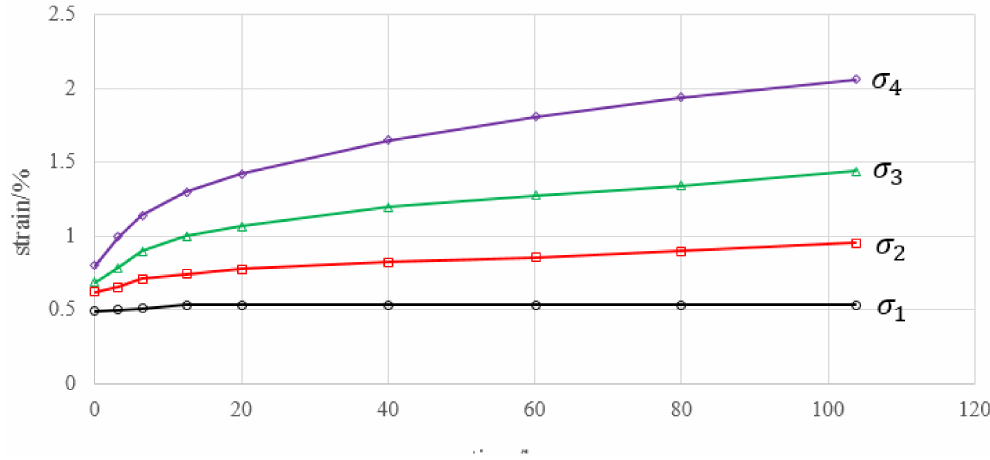
Figure 16. Estimated creep strains under single-step loading of anhydrite rock